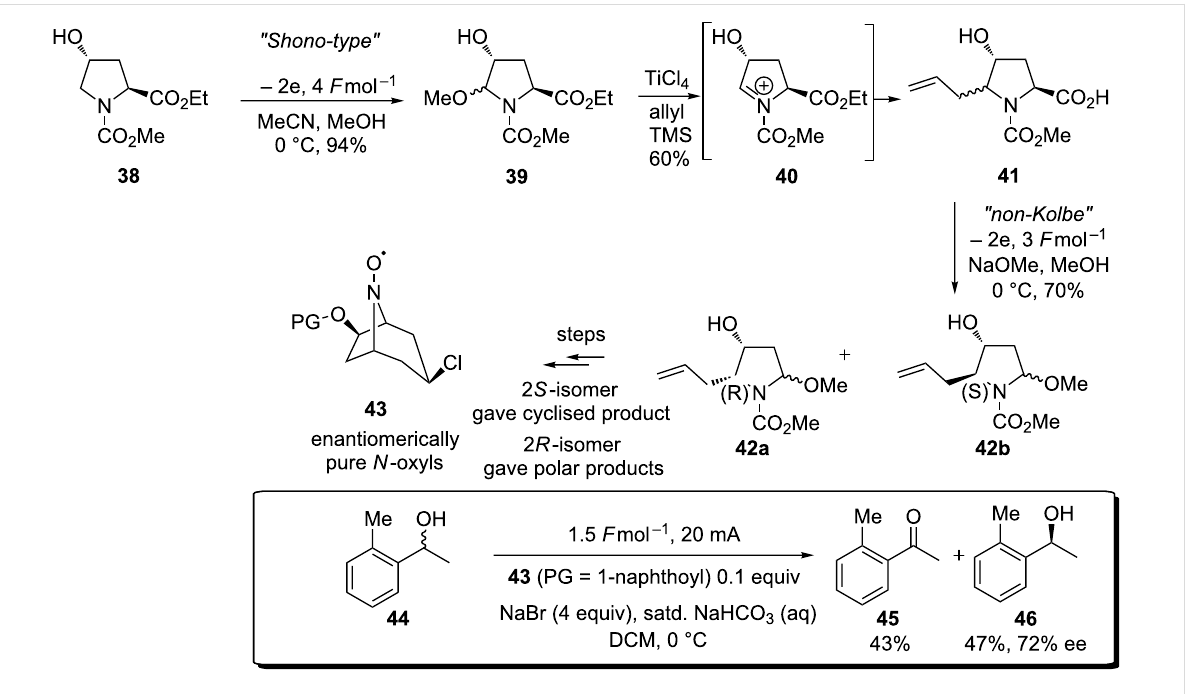
Scheme 9: Electrooxidation to prepare a chiral oxidation mediator and application to the kinetic resolution of sec -alcohols